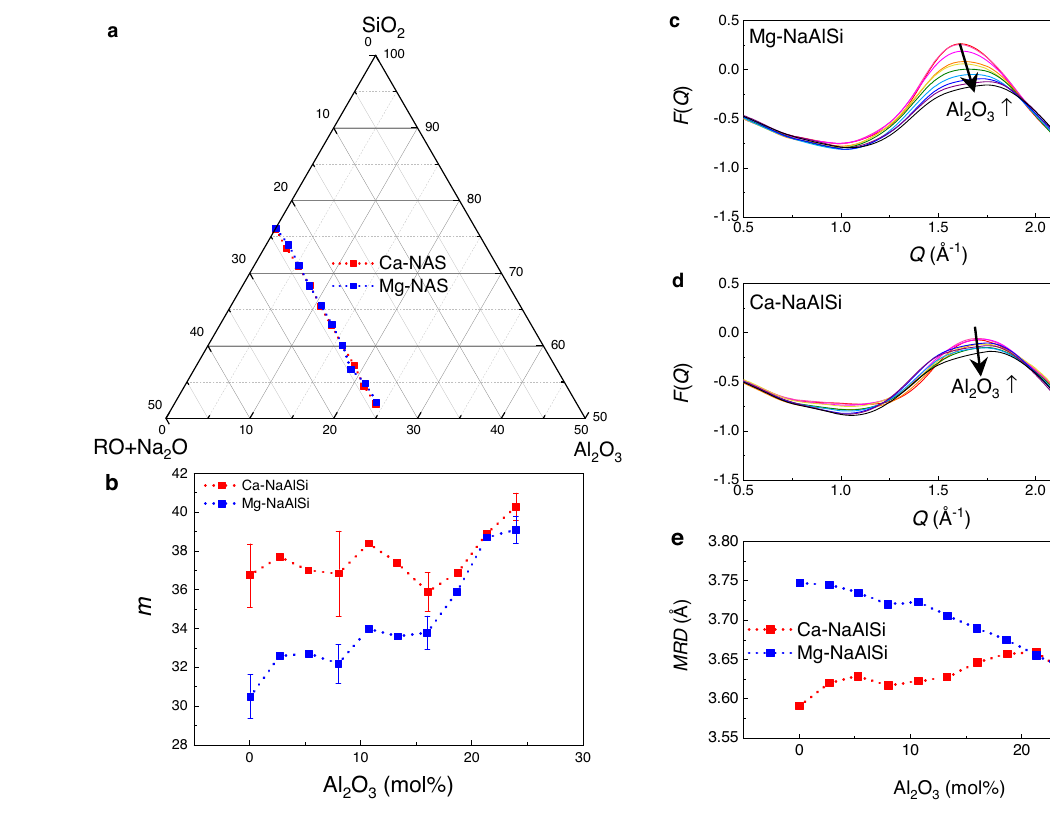
Fig. 3 | Inverse correlation of m - MRD for Group II 20 MgO/CaO NAS glasses. a CompositionsofCa-NAS(red)andMg-NAS(blue)glasses,asshownintheternary phasediagraminmol%. b Fragilityvalues( m )asafunctionofAl 2 O 3 mol%fortenCa- NAS(red)and tenMg-NAS(blue)glasses.The changing trendsof m are inline with thechangingtrendsof MRD ( e )derivedfromtheroom-temperature F ( Q )-FSDPsfor Mg-NAS( c ) and Ca-NAS( d )glasses.In ( c )and ( d ),thearrowindicates the direction of Al 2 O 3 mol% content increase; the red color pattern is for non-Al 2 O 3